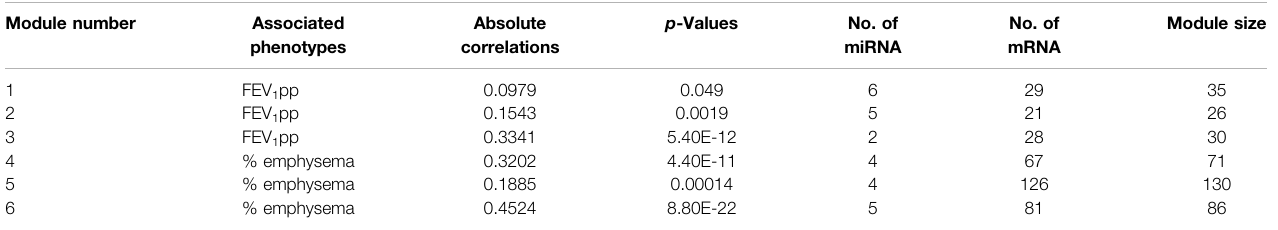
TABLE 3 | Summary of miRNA – mRNA networks associated with